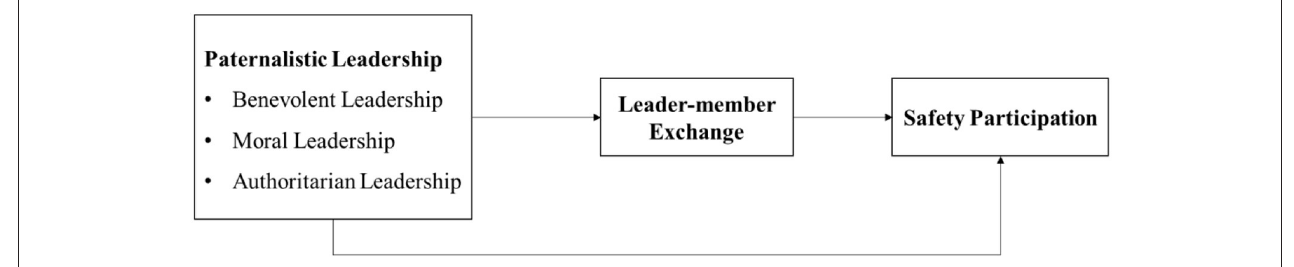
FIGURE 1 | Conceptual model.